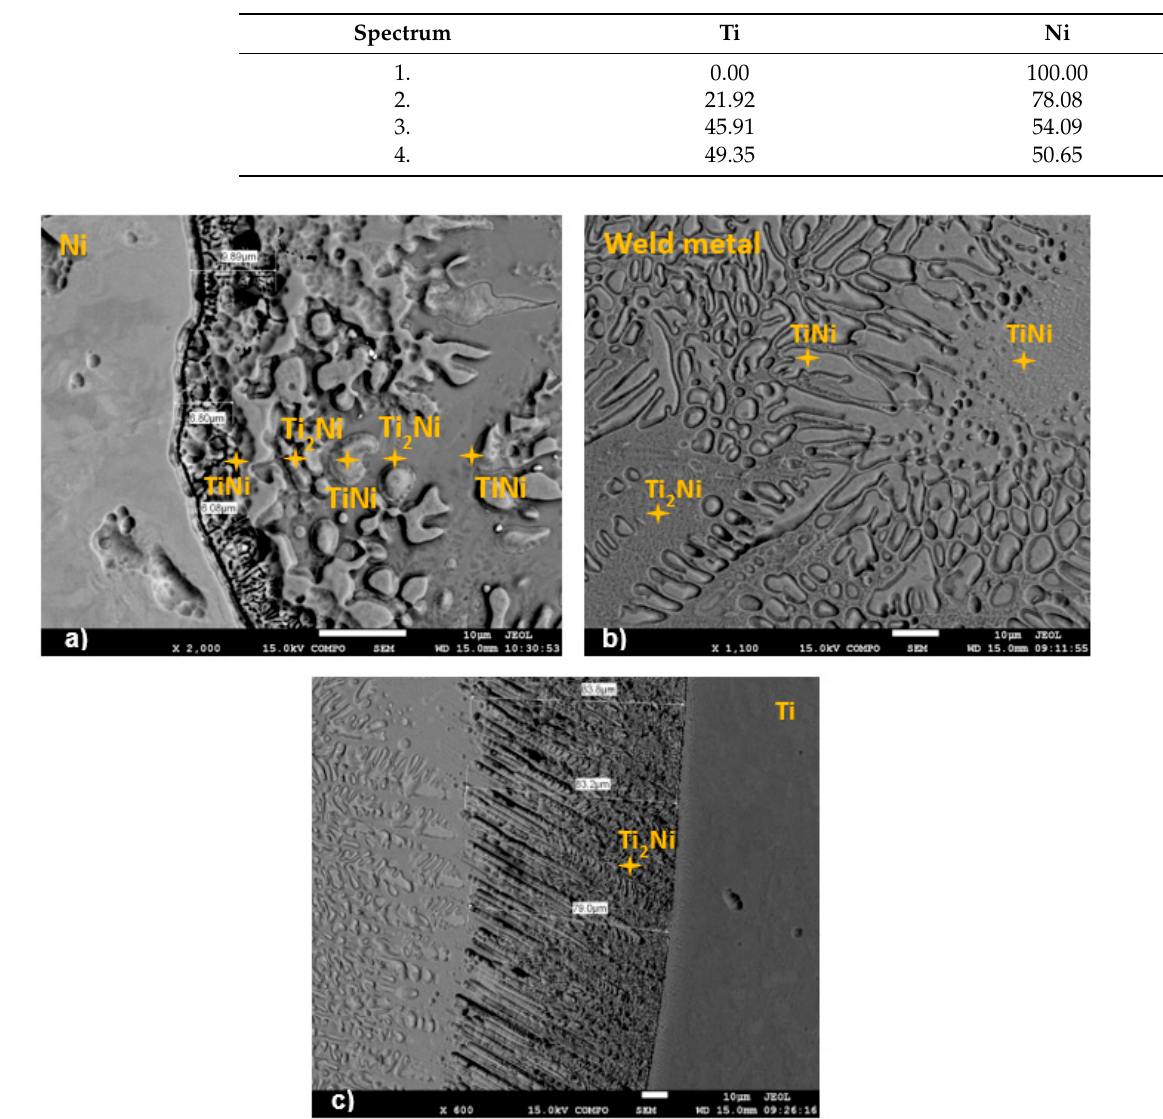
Figure 10. SEM analysis of the Ni–HAZ–weld metal interface of weld 8 ( a ); high magnification of weld metal area ( b ); weld metal–Ti HAZ interface ( c ).